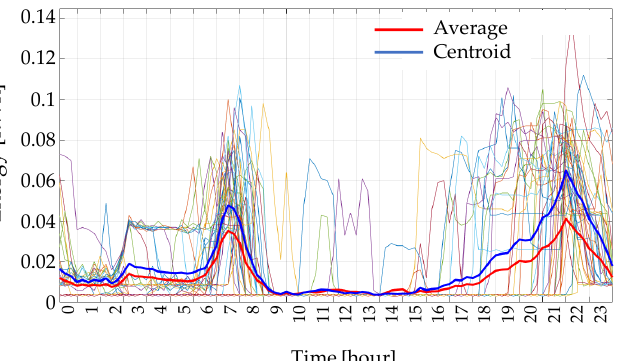
Figure 7. Comparison between the centroid of the most crowded cluster (blue line) and the average profile of all the first quarter weekday profiles of Figure 6 (red